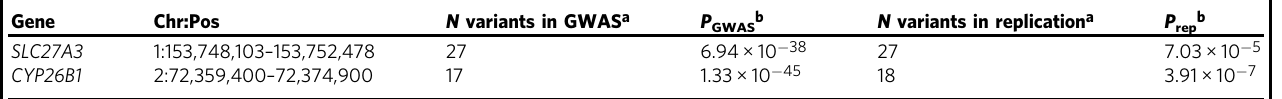
Table 3 Gene-level associations of SLC27A3 and CYP26B1 Gene